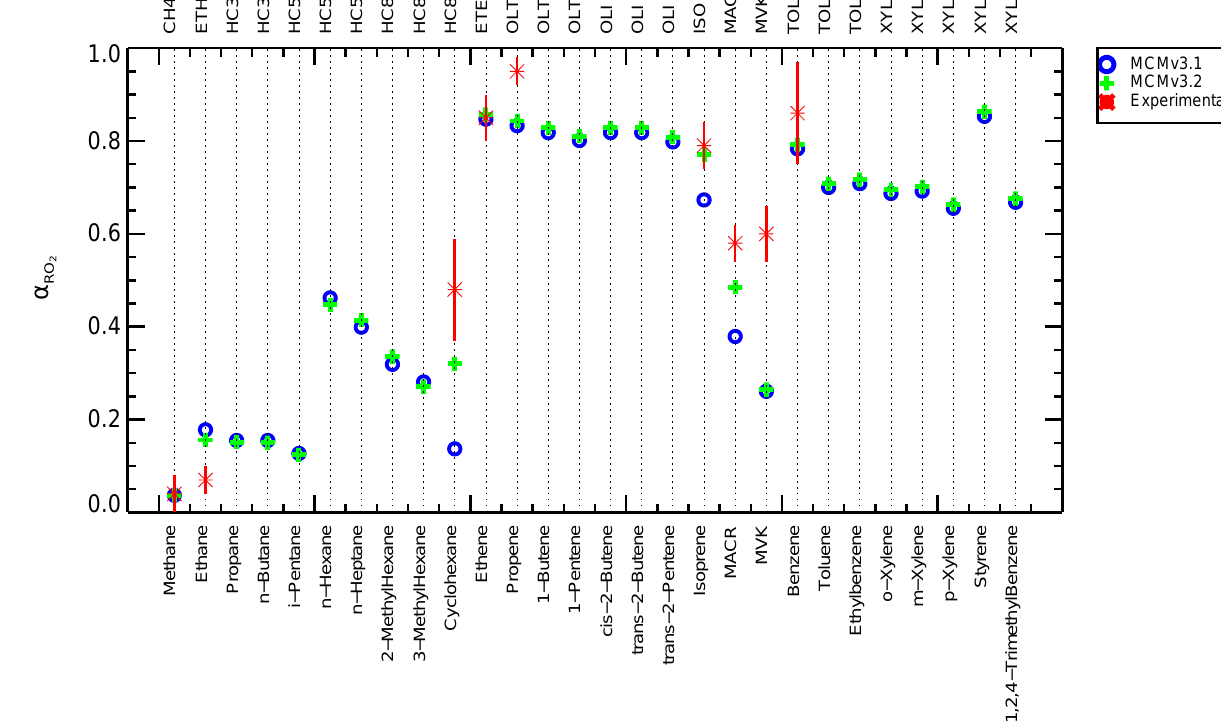
α RO values of about 60 2